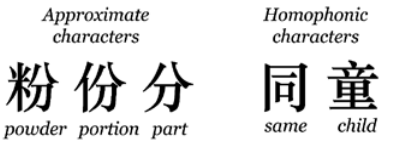
Figure 9: Examples of Approximate and Homophonic Characters.